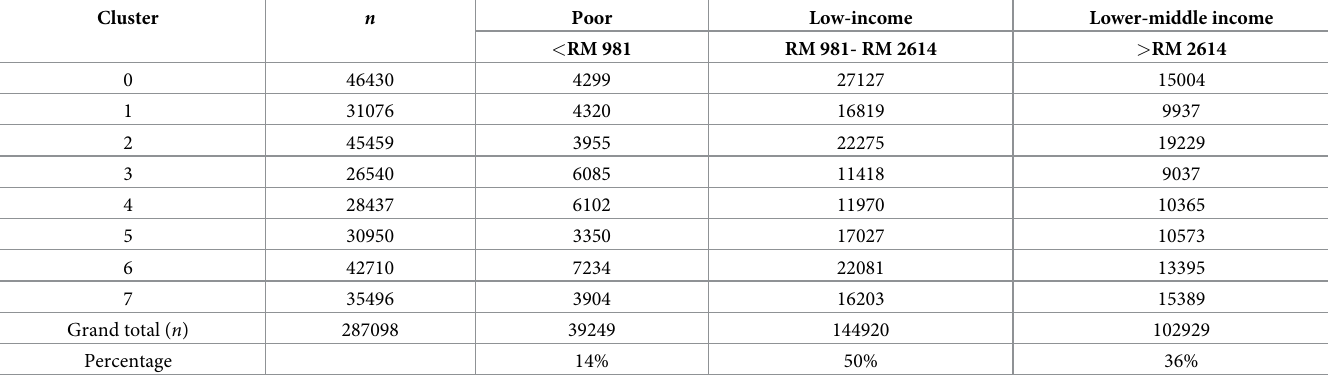
Table 13. Distribution of B40 group based on 2016’s